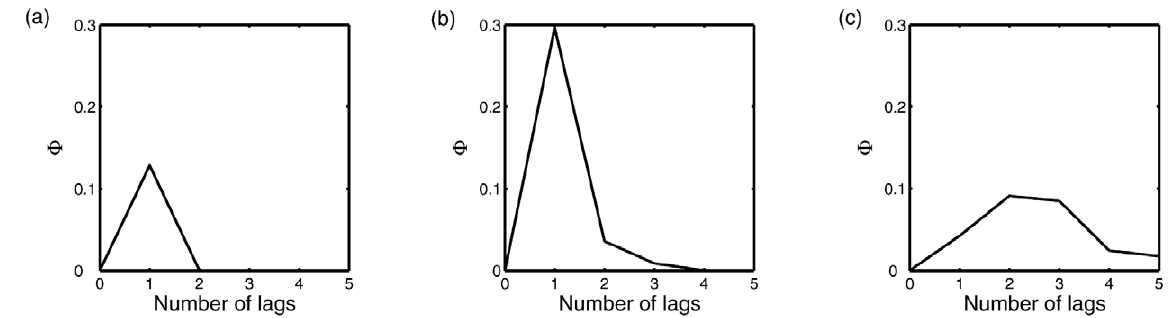
Figure 4. Integrated information, W E measured for states multiple time-steps in the past, i.e. for varying t . (a) Network 1(c). (b) Network 2(b). (c) Example MVAR(3) process, see Eq.